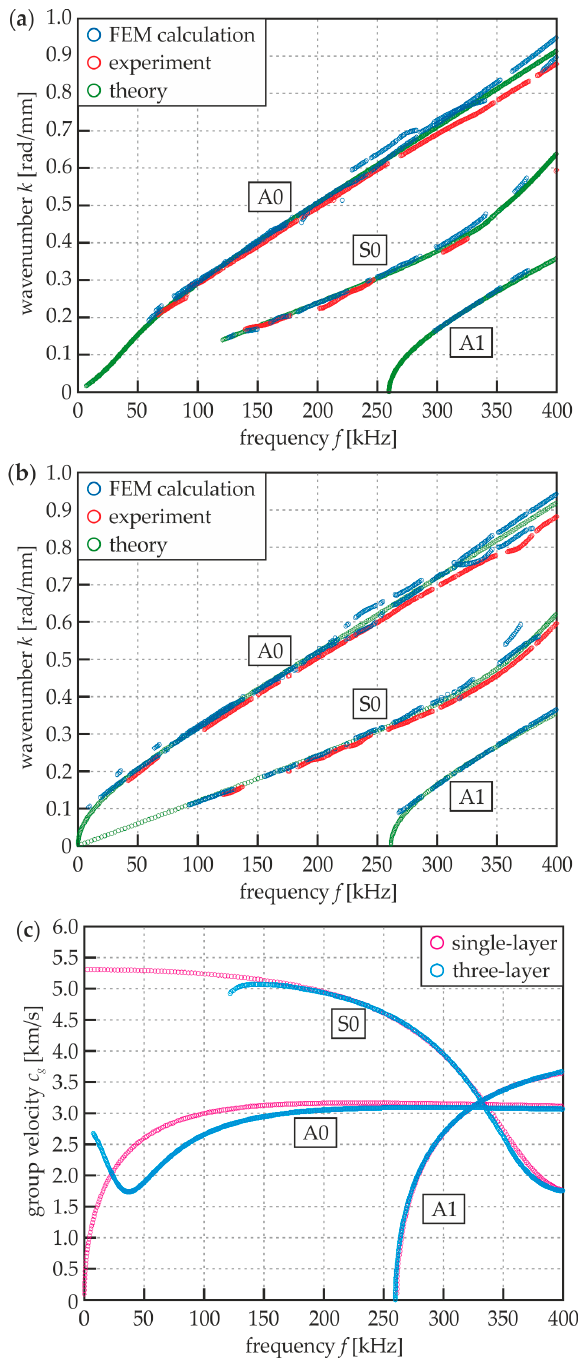
Figure 5. Dispersion curves for analyzed specimens: ( a ) wavenumber vs. frequency for three-layer plate #1; ( b ) wavenumber vs. frequency for single-layer steel plate #5; and ( c ) theoretical group velocity vs. frequency for three-layer plate #1 and single-layer plate #5.